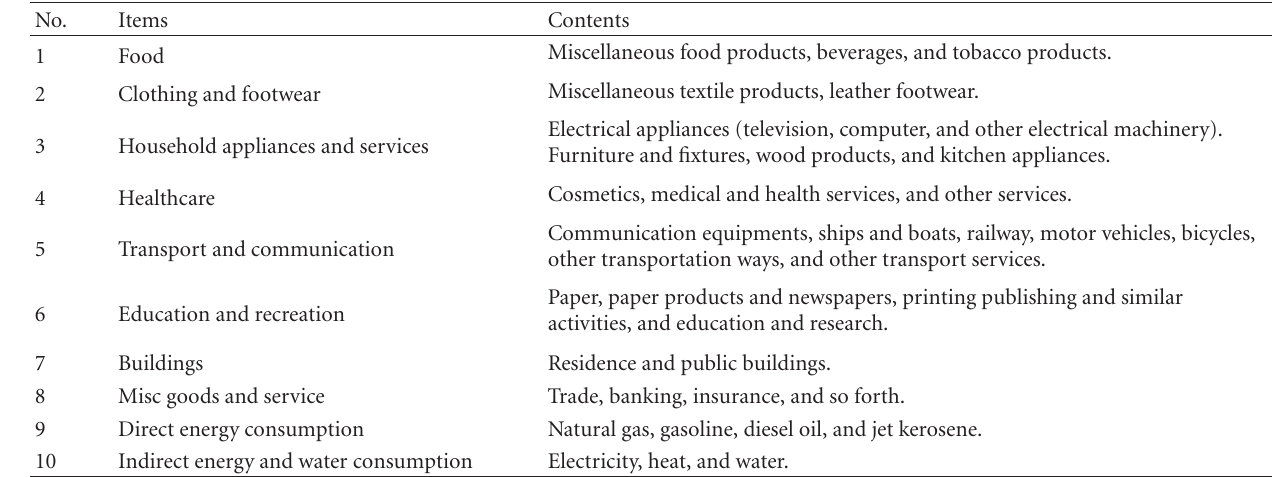
Table 2: Consumption categories of the